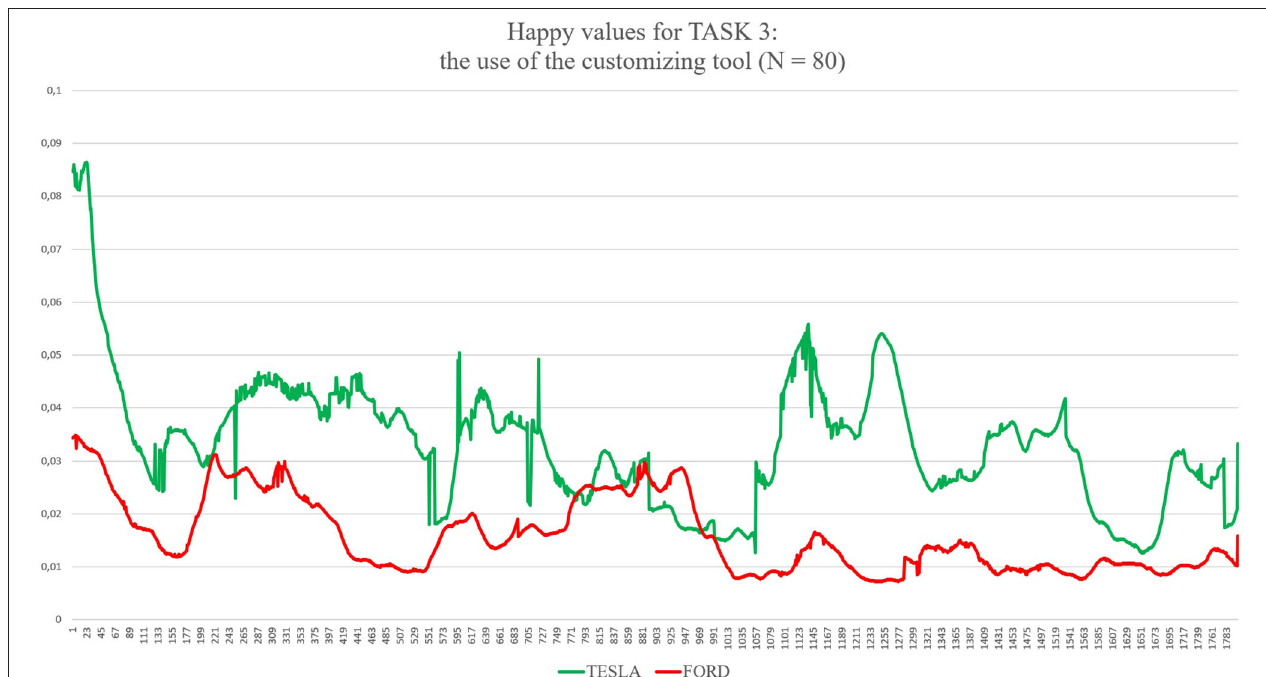
FIGURE 3 | The graph shows values for Happiness both for Tesla and Ford during Task 3 (subjects were asked to use the customising tool). On the X axis, time is expressed in 30 samples per second for a total of 1,800 samples, corresponding to 60s as the total maximum amount of time exposure to the websites for this task. On the Y axes values of happiness are expressed between 0 (no happiness expressed by the face) and 1 (highest intensity of happiness expressed by the face).